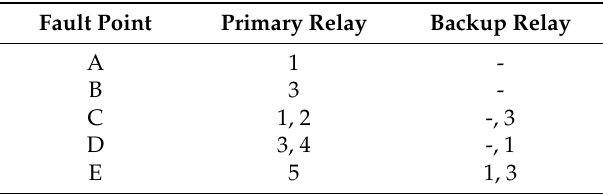
Figure 6. A single end fed parallel feeder distribution system. Table 5. Primary and backup relationships of the relays for Case II.